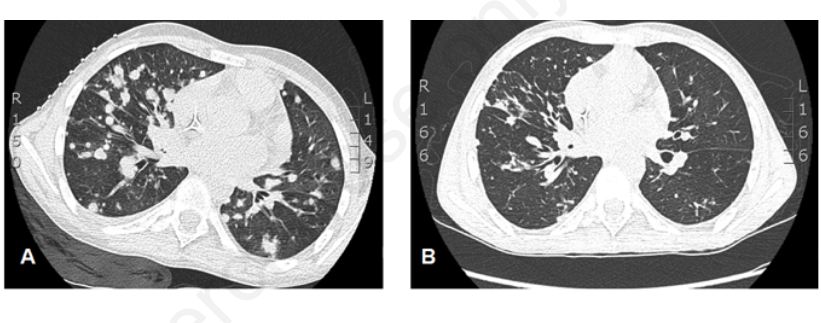
Figure 1. HRCT during the first course of Nivolumab treatment. A) Before Nivolumab administration HRCT showed multiple nodules in the lungs bilaterally. The CT guided